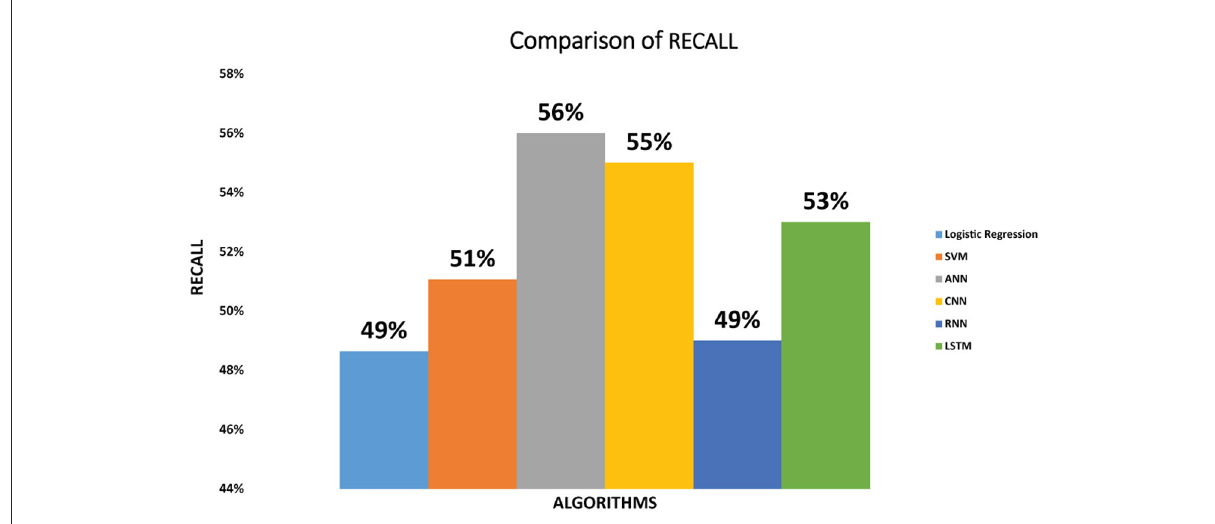
FIGURE4 Comparison of recall for logistic regression, SVM, ANN, CNN, RNN, and LSTM.